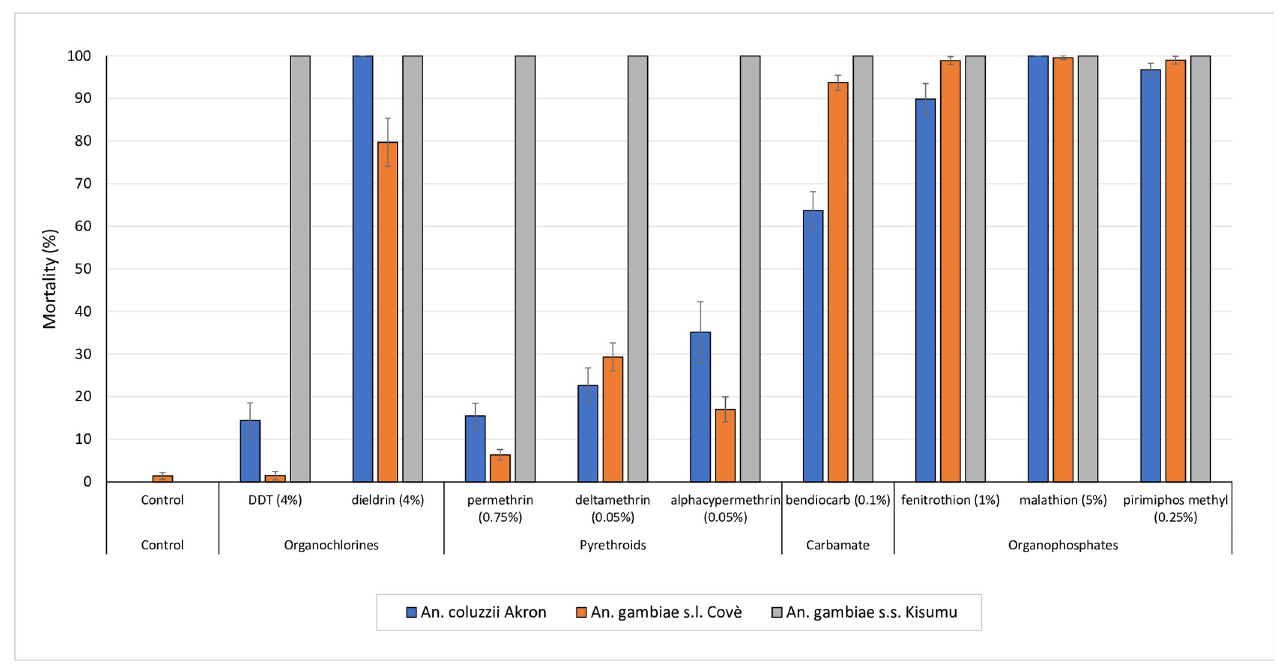
Fig 1. Susceptibility of An . gambiae s.s. Kisumu, An . gambiae s.l. Cov è and An . coluzzii Akron exposed to discriminating concentrations of insecticides in WHO cylinder bioassays. Data was pooled from routine testing on insectary-maintained mosquito strains performed between February 2020 and December 2021. Error bars represent 95% confidence intervals.